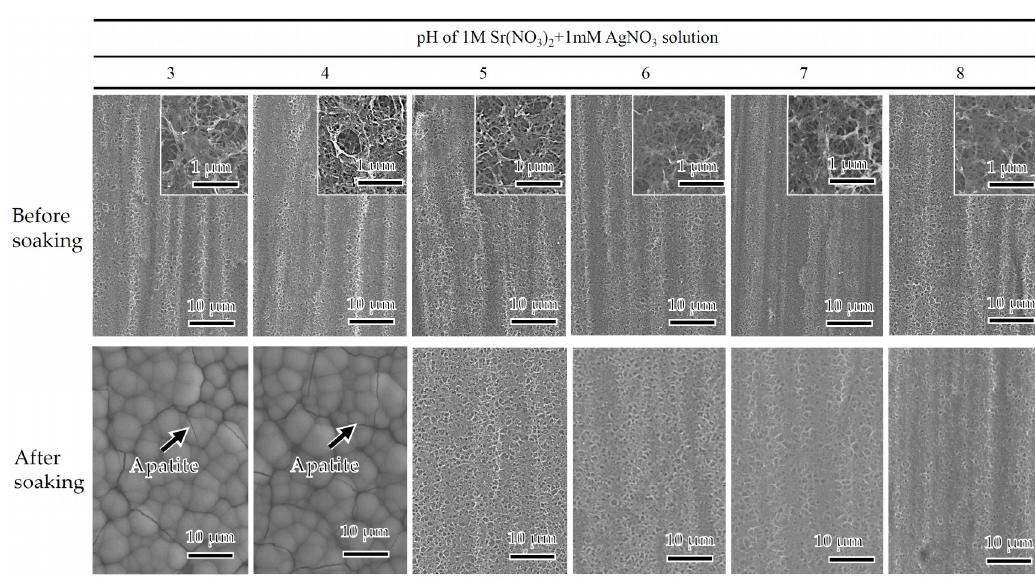
Figure 4. SEM images of the surfaces of Ti before and after soaking in SBF for 3 days that has been subjected to Sr + 1 mM Ag treatment with various pH following NaOH, Ca + Sr and heat treatment. Small windows show high magnification images on Ti before soaking in SBF. The digits in the table above the images stand for pH of 1 M Sr(NO 3 ) 2 + 1 mM AgNO 3 solution in the final solution treatment.